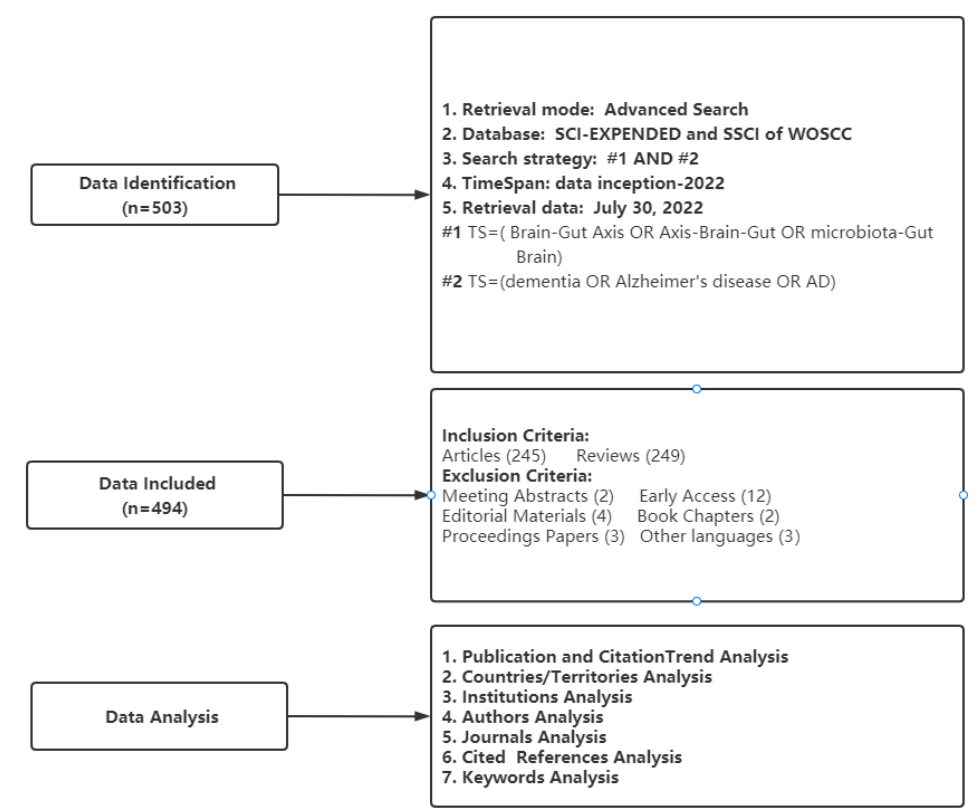
Figure 1. Flowchart of data selection and analysis.